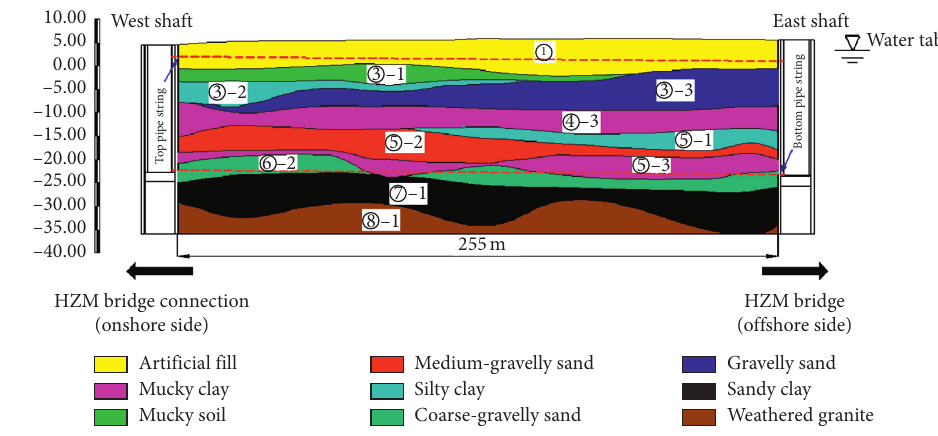
Figure 3: Geological profile of the Gongbei tunnel. Table 1: Physical and mechanical parameters of the